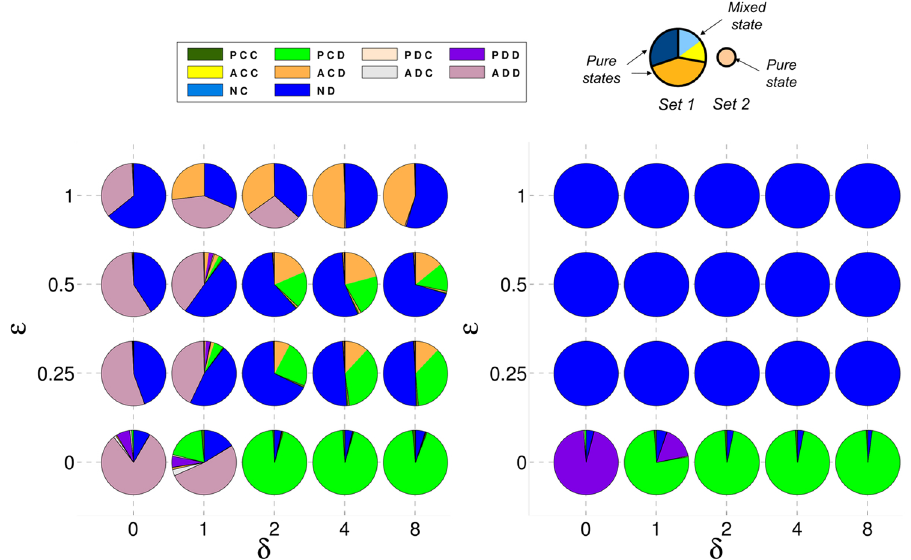
Figure 2. Mixed states between proposers and acceptors are necessary to maintain pure defectors at bay in PC games. Composition of the recurrent sets for PC one-shot games. Same as Fig. 1 but for PC type